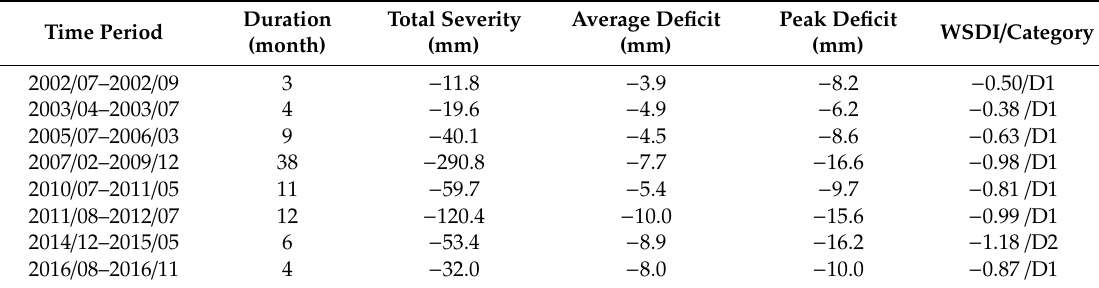
Table 2. Summary of GRACE − identified drought events and drought severity categories based on the WSD and WSDI of Mongolia.